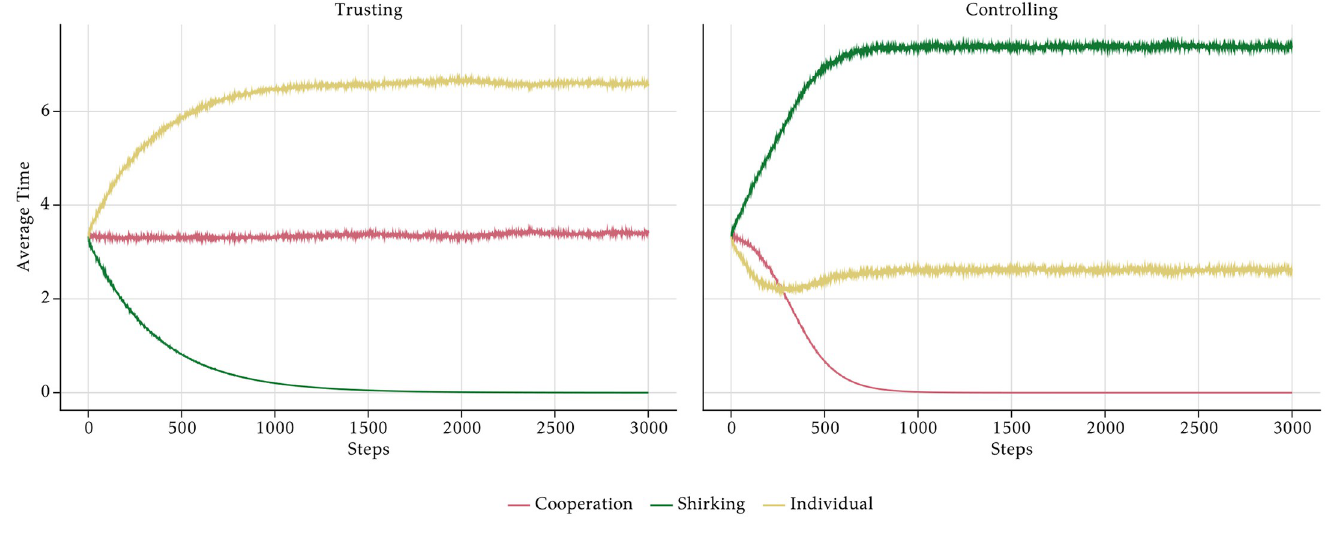
Fig 12. Aggregate average time—No incentives.